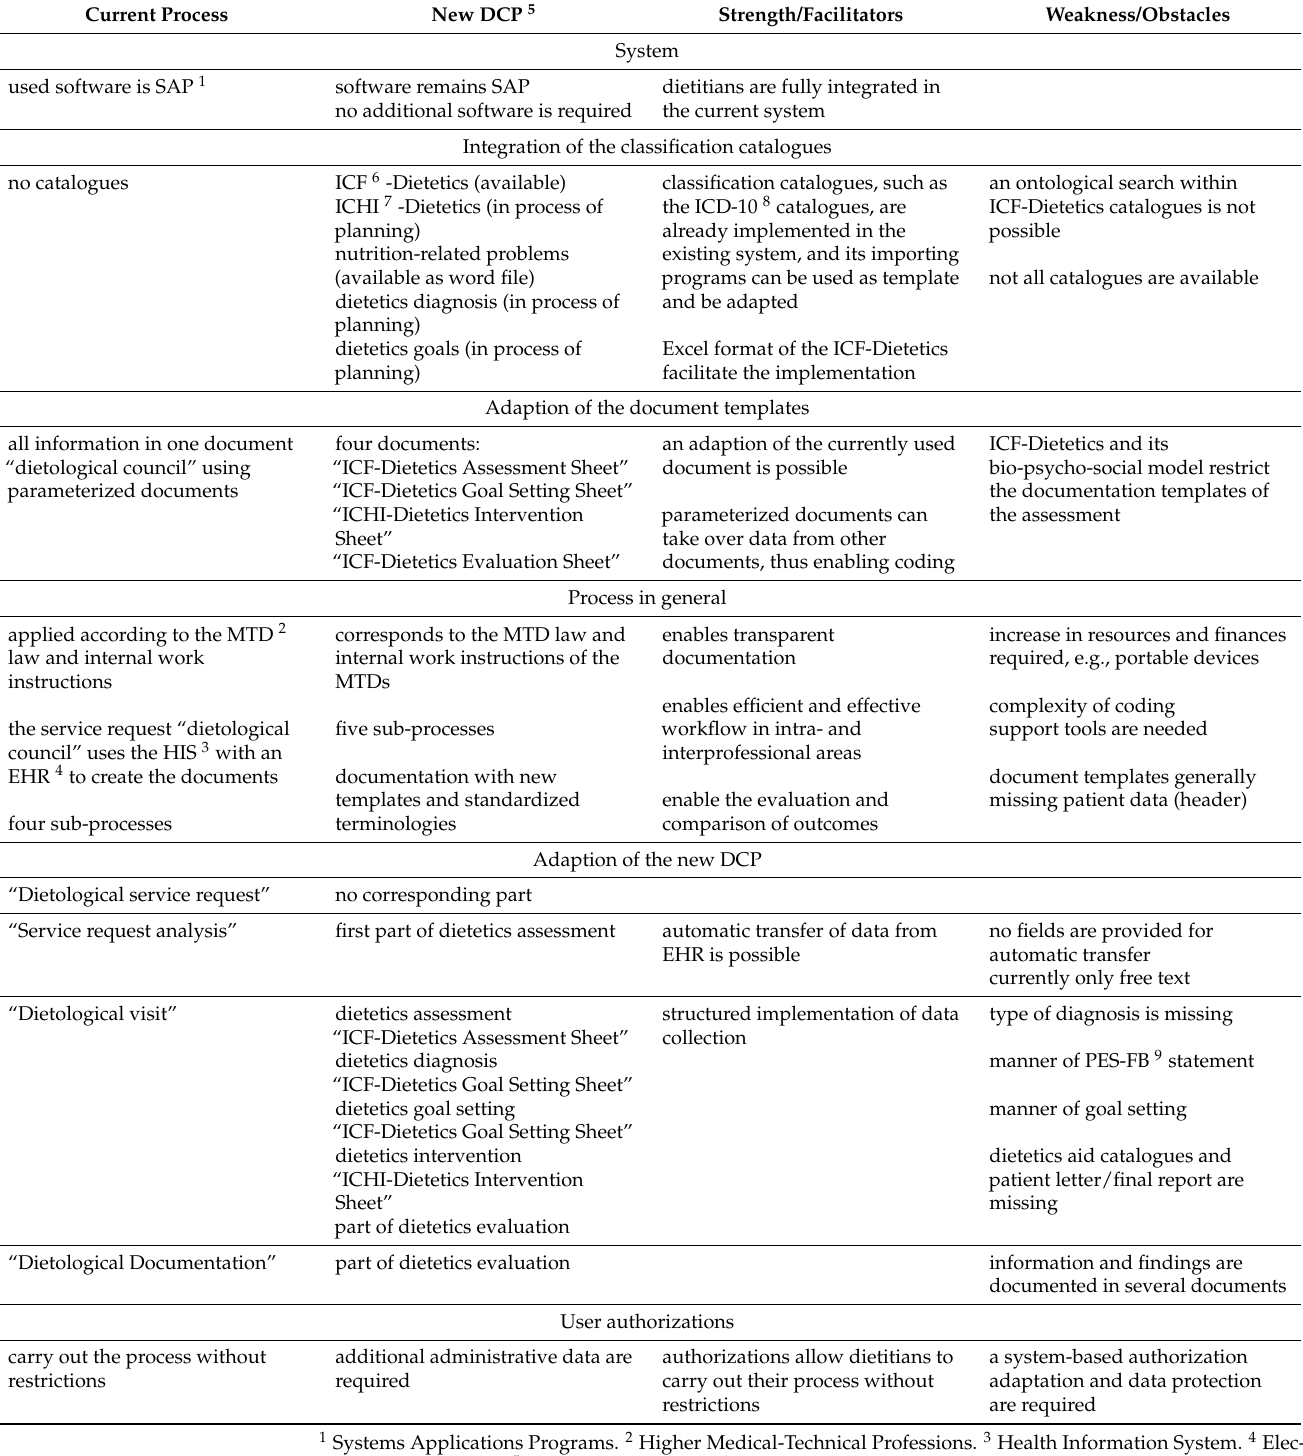
Table 1. Summary of results mapped against the four criteria for the system and process integration: “integration of the classification catalogues”, “adaption of the document templates”, “adaption of the new DCP”, and “user